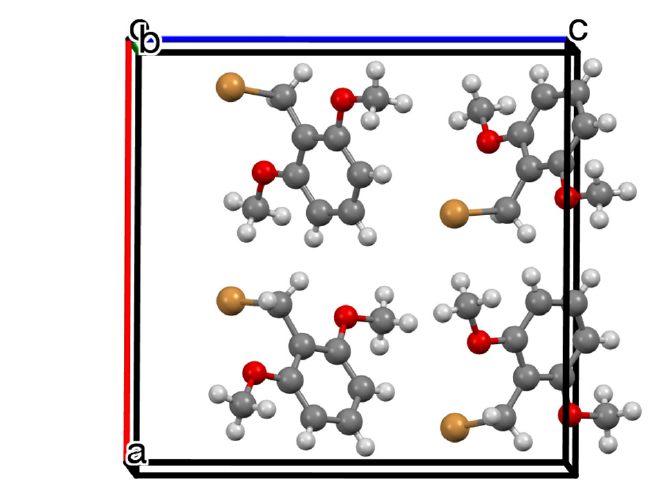
Figure 2. ( left ) Molecular structure of 1 with anisotropic displacement ellipsoids drawn at 50% probability level and showing numbering system used. ( right ) View of unit cell along the b axis showing packing.